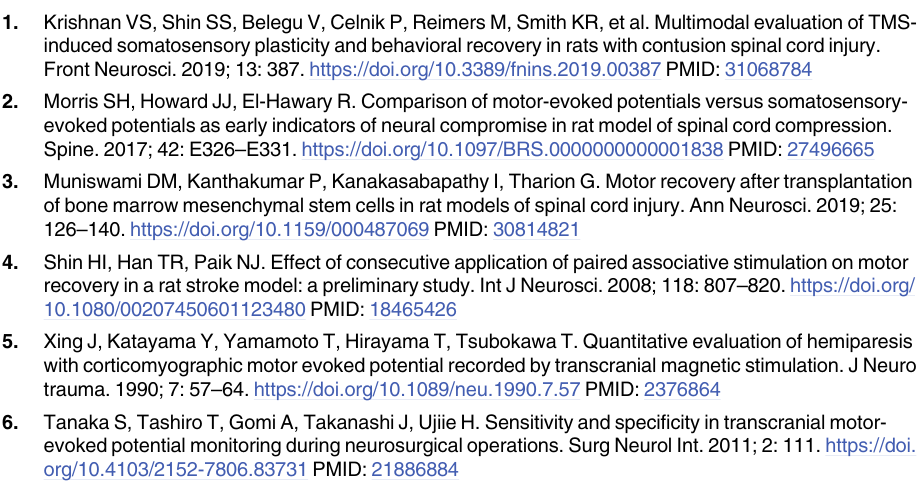
S1 Fig. Lineage-specific assessment following the differentiation of rat bone marrow- derived mesenchymal stem cells (rbMSC) and rat cranial bone-derived mesenchymal stem cells (rcMSC). (A) Alizarin red S staining following the osteogenic differentiation of rbMSCs and rcMSCs. (B) Oil red O staining following the adipogenic differentiation of rbMSCs and rcMSCs. Scale bars, 50 μ